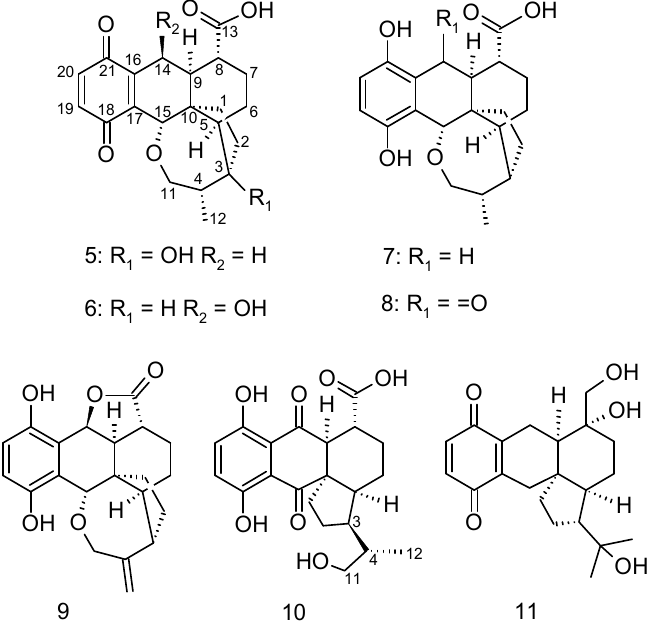
Figure 2. Chemical structures of newly isolated compounds 5 – 11 .